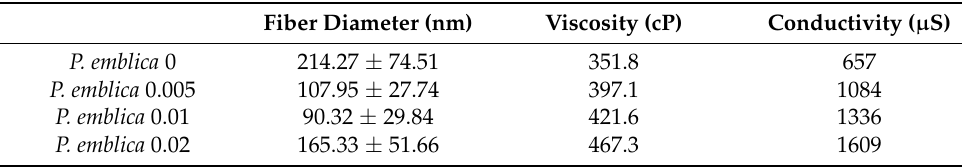
Table 3. Specifications of PVP/WCS/ P. emblica nanofiber